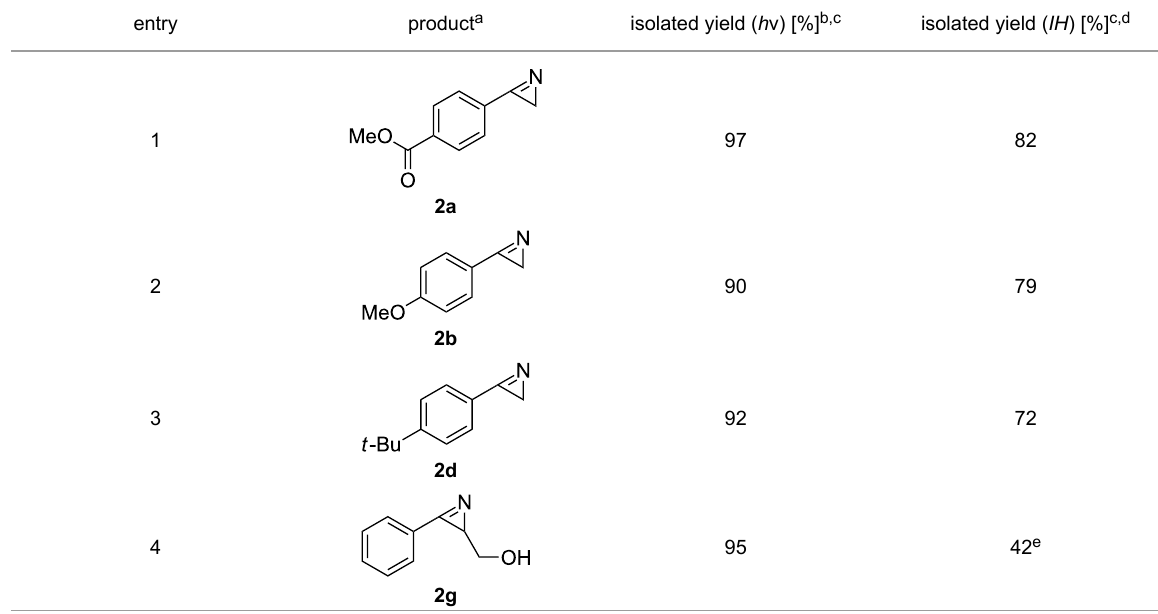
Table 1: Continuous synthesis of 2H- azirines 2 under inductive heating and photochemical conditions. The experiments were conducted at a concen- tration of 0.05